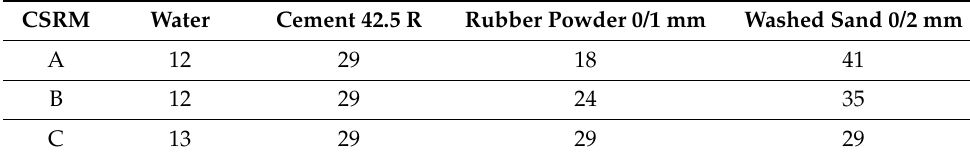
Table 2. Mortars composition (m/m) [%].